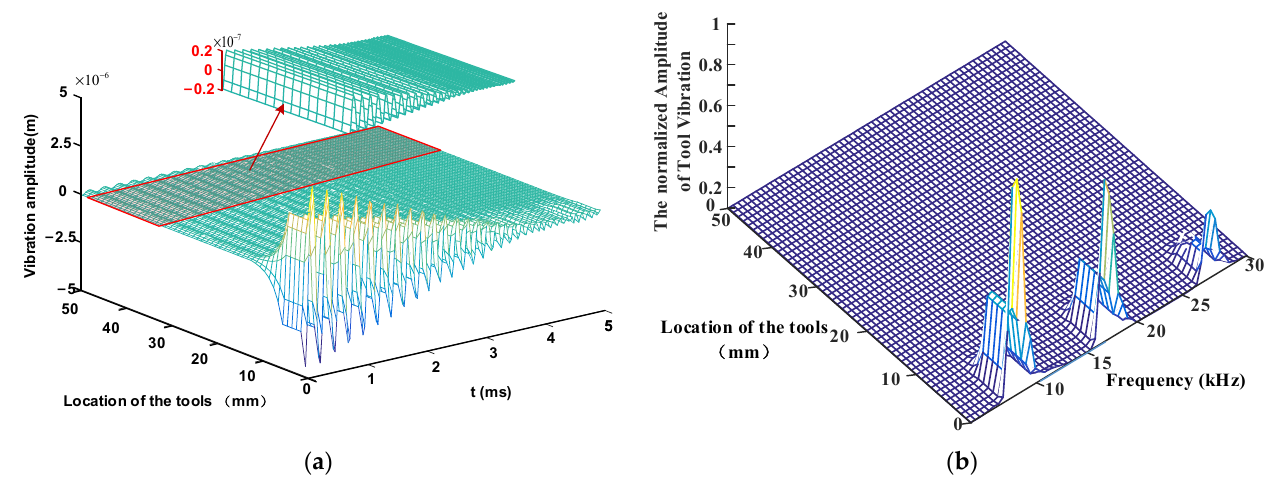
Figure 8. Impact response of the tip of Tool B.